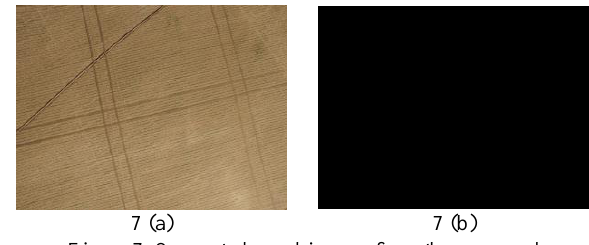
Figure 7. Generated weed images from the proposed methodology.